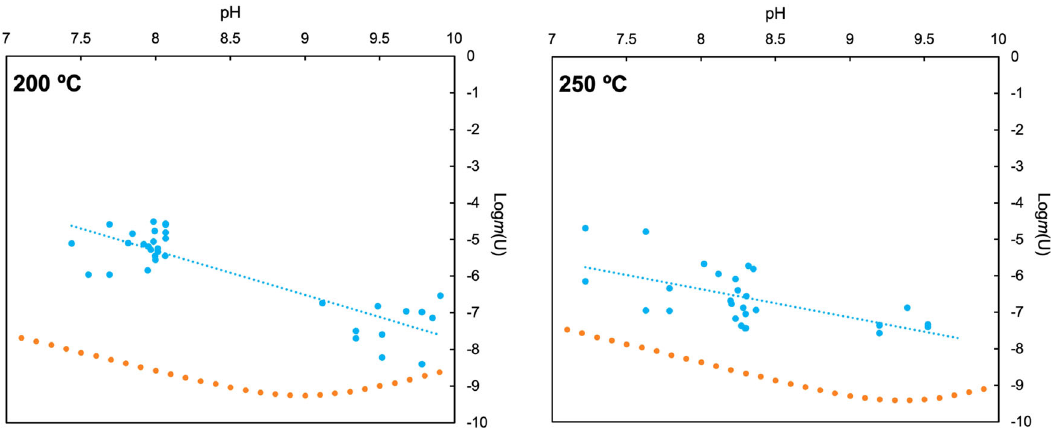
Fig. 4 Measured and calculated solubilities of UO 2 (OH) 2 plotted as functions of pH at temperature at 200 and 250 °C. Measured solubilities and trend line are shown in dark blue. Calculated solubilities (assuming no uranyl carbonate speciation) are shown in light blue. Calculated solubilities suggest a predominance of UO 2 OH + over most of the pH range shown with a shift towards UO 2 (OH) 2 (aq) then UO 2 (OH) 3 − predominance at pH values > ~9 – 9.5 as indicated by gradients of 0 and 1 consistent with the reactions [UO 2 (OH) 2 (s) ⇌ UO 2 (OH) 2 (aq)] and [UO 2 (OH) 2 (s) + H 2 O ⇌ UO 2 (OH)3 − + H +